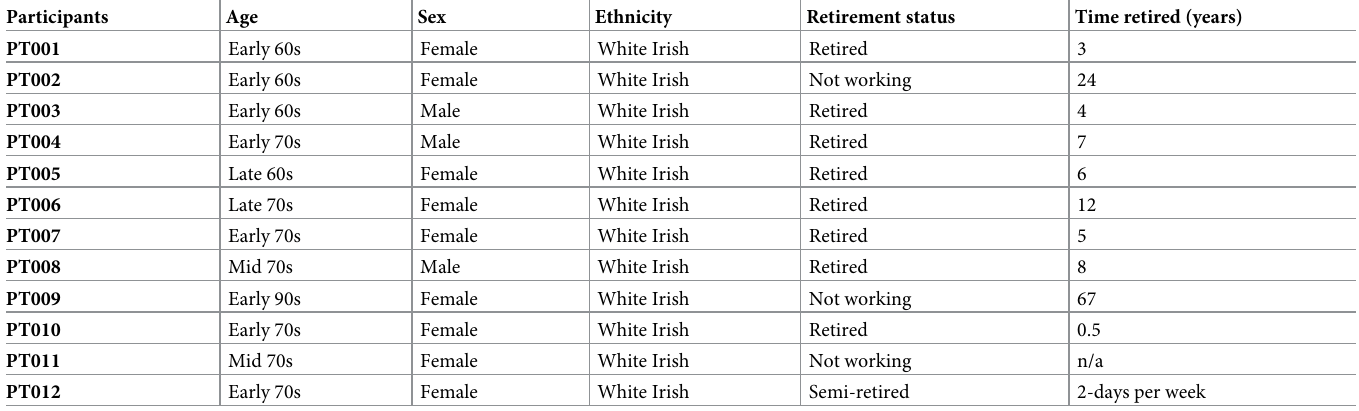
Table 3. Participant Demographic Information